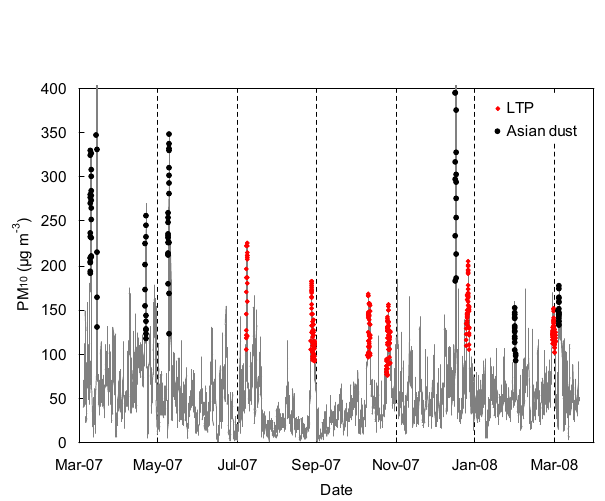
Fig. 10. Temporal variation of PM 10 mass concentration in Seoul, Korea during the entire measurement period. Red and black cir- cles represent long-range transport pollution (LTP) and Asian dust periods,